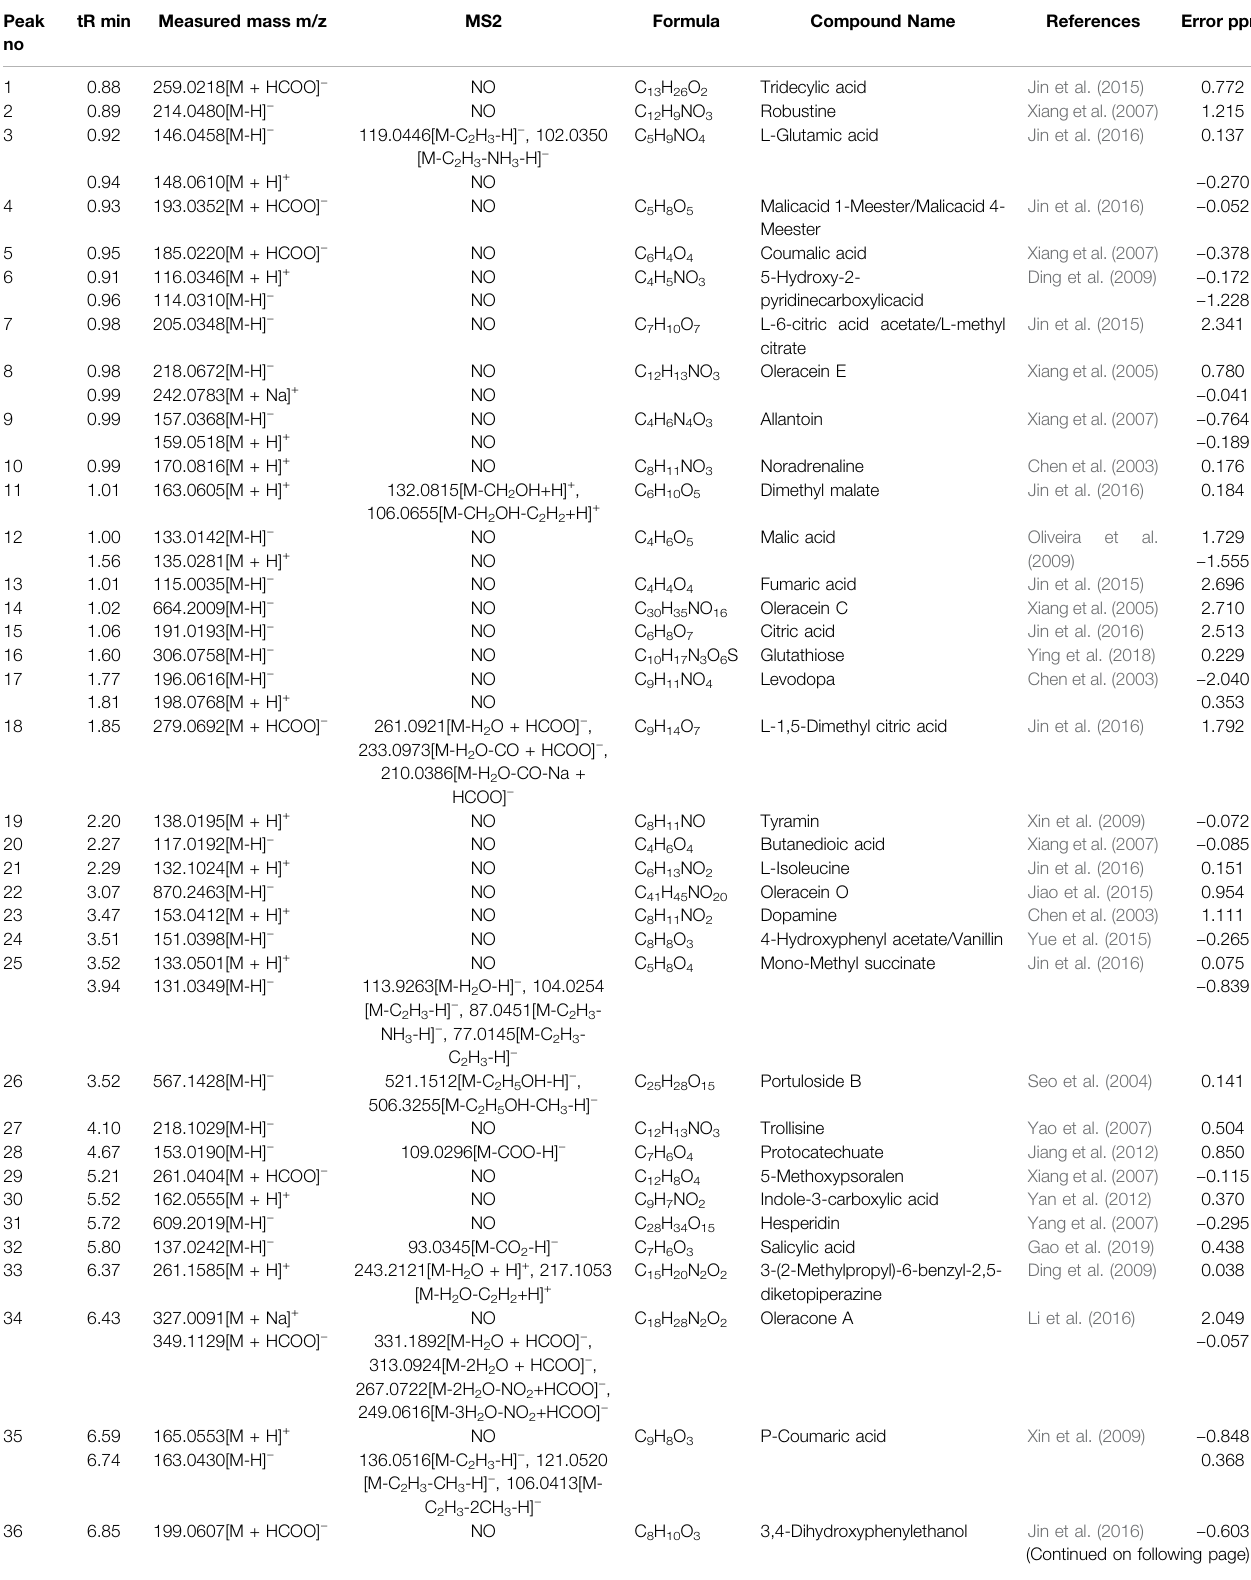
TABLE 1 | Identi fi cation of chemical compounds in MCXZ by